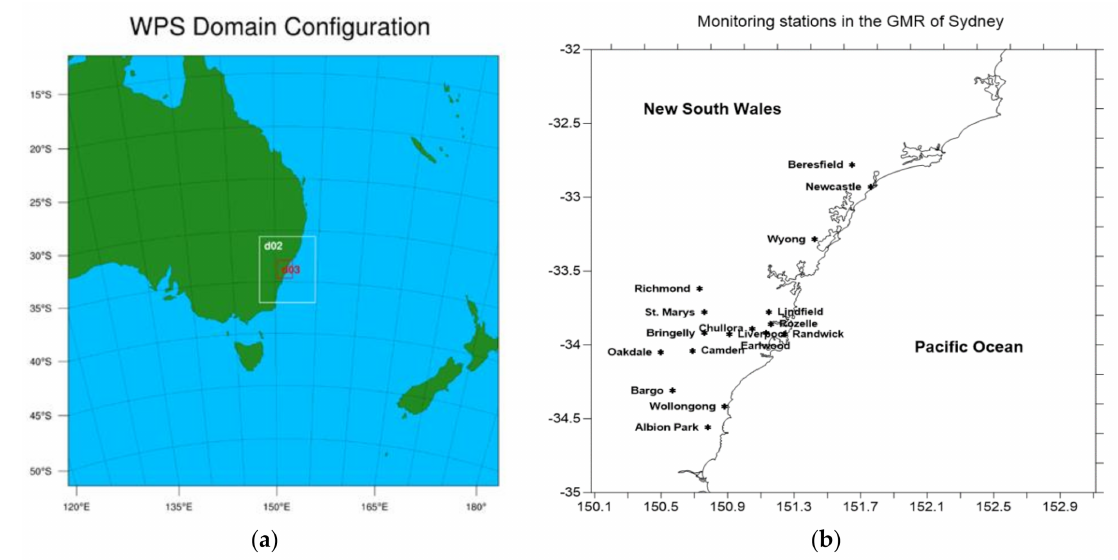
Figure 3. ( a ) WRF-Chem domain configuration over eastern Australia; ( b ) DPIE air quality monitoring stations in the Greater Metropolitan Region (GMR) of Sydney which is defined as domain d03 (the red rectangle in ( a